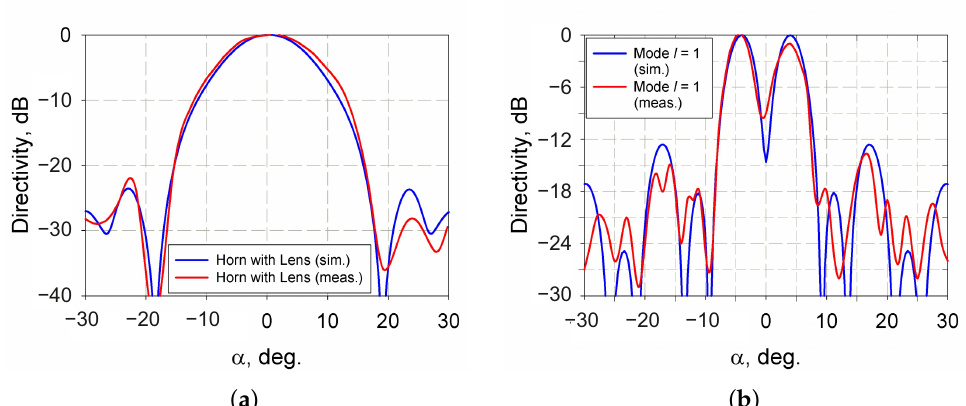
Figure 4. Comparison of the simulated and measured beam of a horn with mode with l = 0 ( a ); comparison of the simulated and measured beam of mode with l = +1 ( b